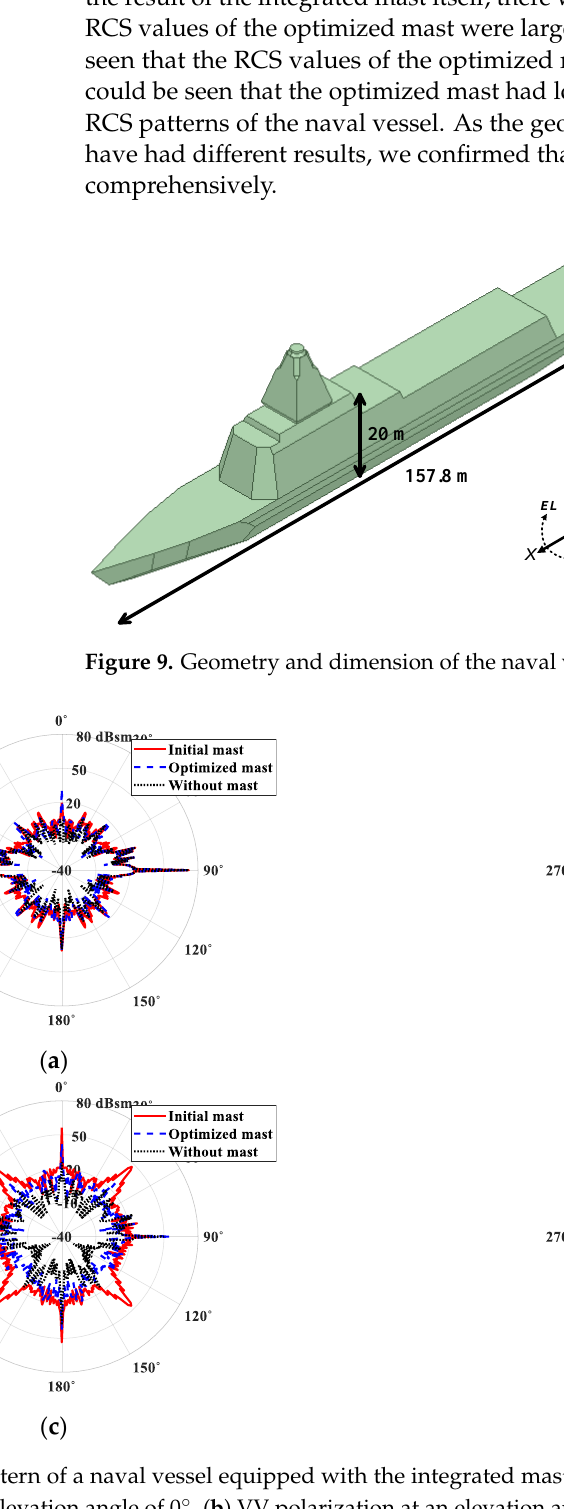
( d ) Figure 11. RCS pattern of a naval vessel equipped with the integrated mast in the azimuth plane in the S-band. ( a ) HH polarization at an elevation angle of 0°, ( b ) VV polarization at an elevation angle of 0°, ( c ) HH polarization at an elevation angle of 10°, ( d ) VV polarization at an elevation angle of 10°.